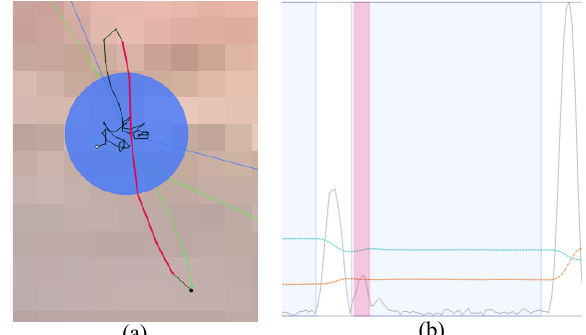
Figure 5 . Eye movement detected as microsaccade (pink); it can be identified as glissade on the stimulus and in the timeline: (a) Connected samples that belong to the microsaccade are located at the beginning of the fixation (black). (b) Zoomed view of the timeline: the detected microsaccade is located at the beginning of a fixation (blue) right after a saccade. (x values: orange, y values: turquoise, velocity: gray). Example used from the painting data set.